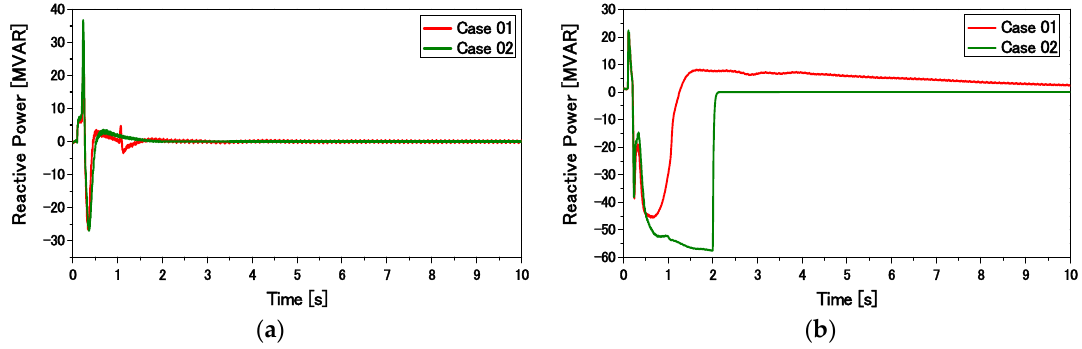
Figure 17. Reactive power output of wind generators: ( a ) DFIG; ( b ) SCIG.